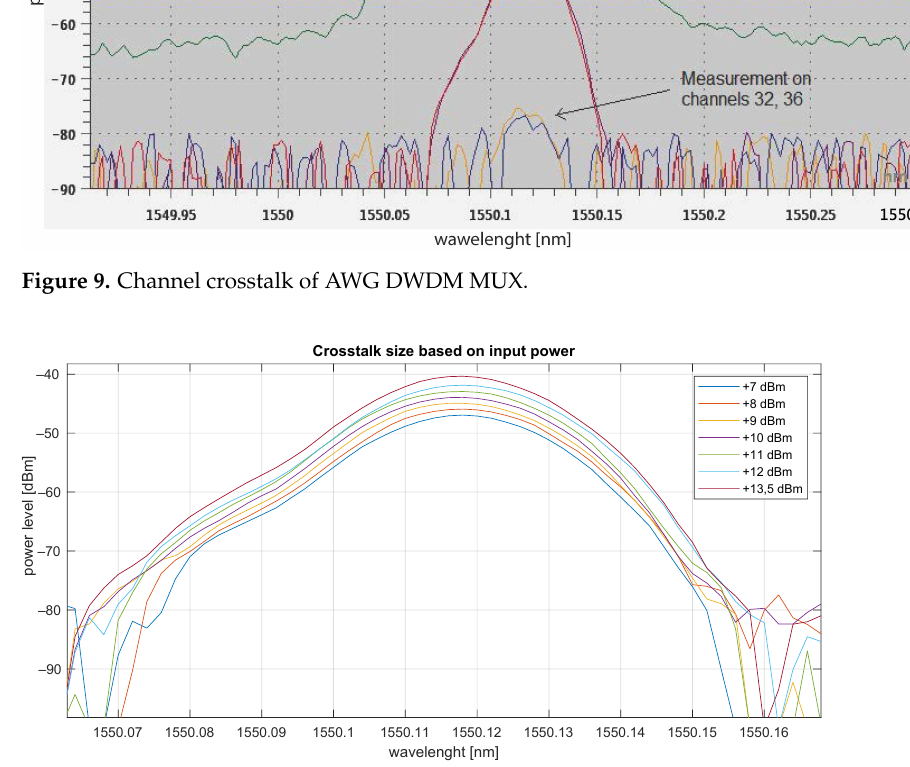
Figure 10. Input power level vs. crosstalk. Table 9. Crosstalk for different laser power